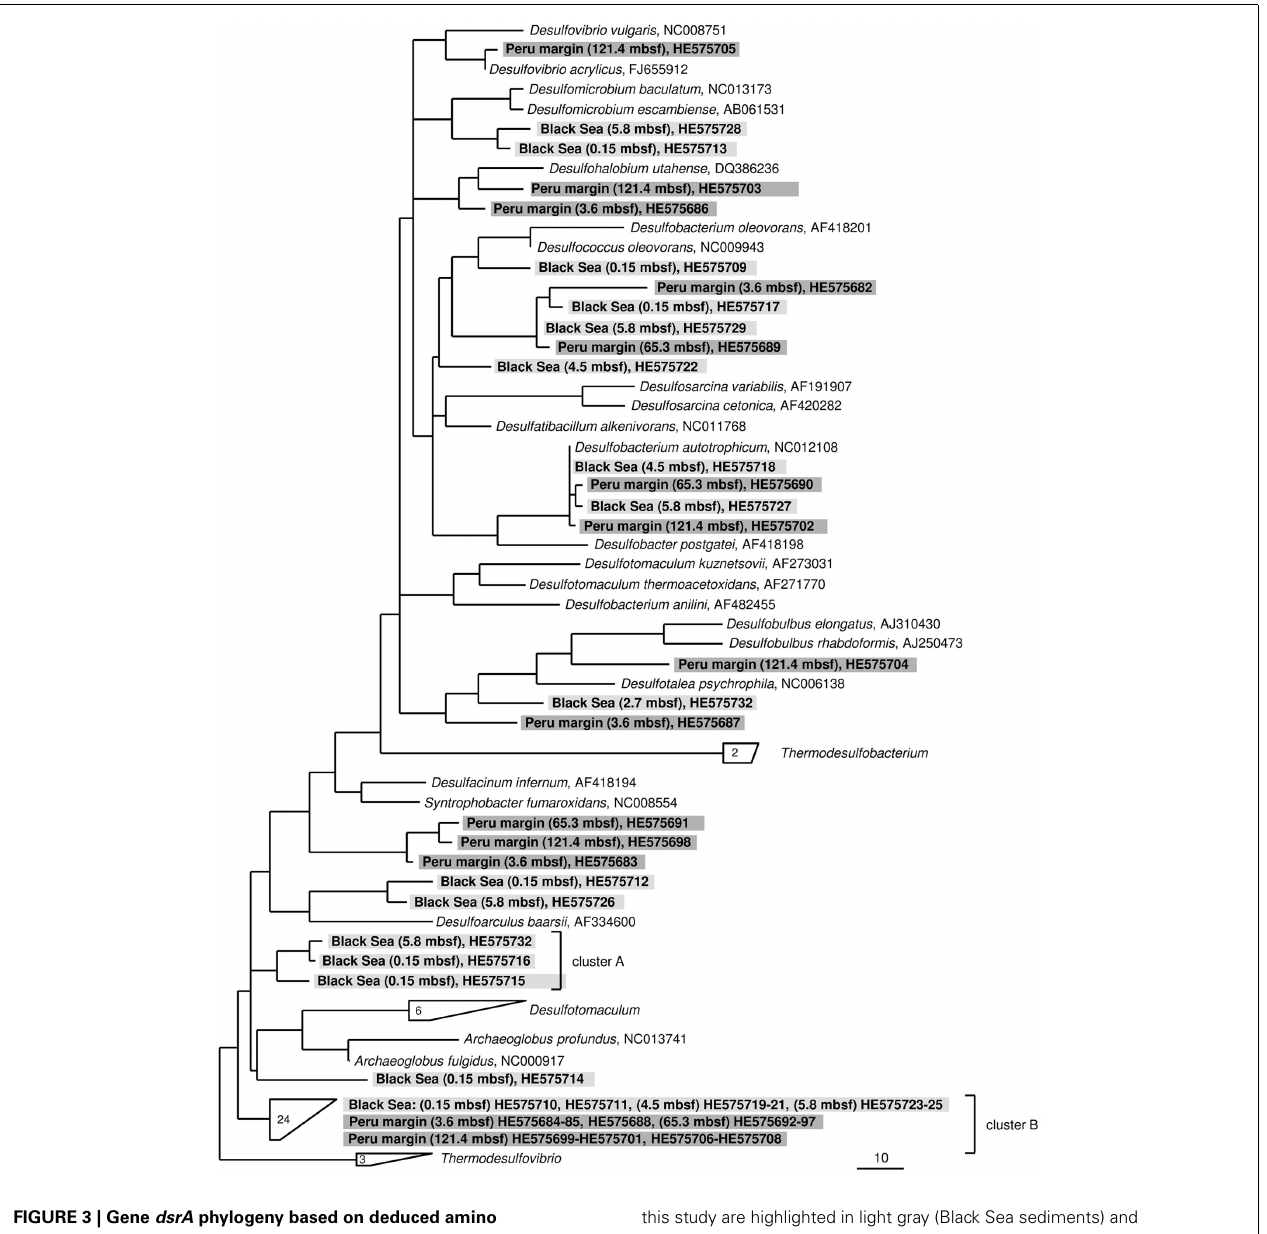
FIGURE 3 | Gene dsrA phylogeny based on deduced amino acid sequences of the dsrA gene coding for the alpha subunit of dissimilatory (bi)sulfite reductase. Sequences from